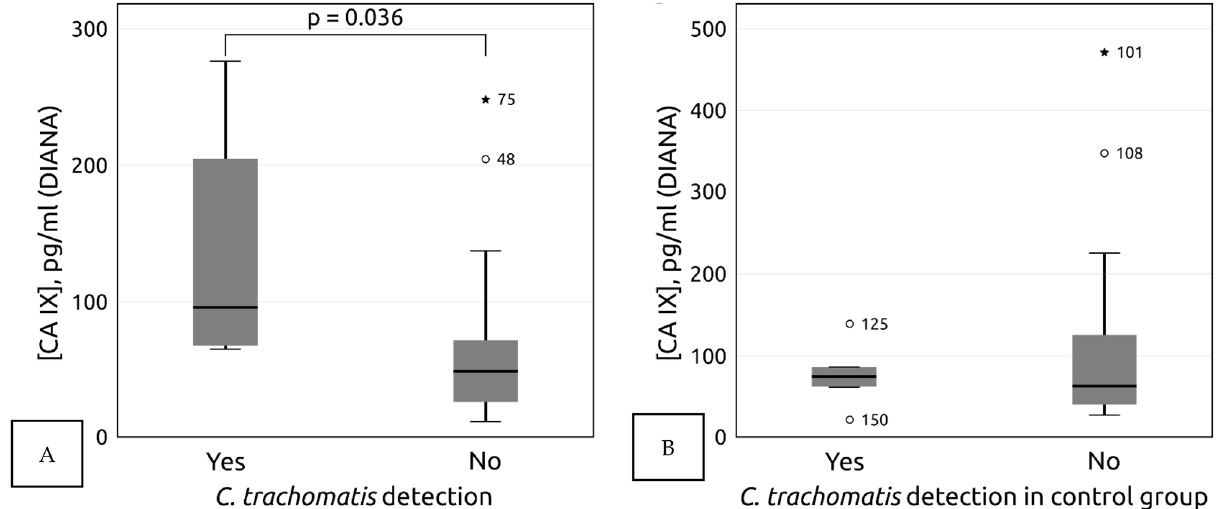
Figure 3. ( A ) Difference of mean s-CAIX level among ≥ HSIL patients (on the left C. trachomatis positive N = 6, on the right and C. trachomatis negative women N = 18). ( B ) Difference of mean s-CAIX level among controls (on the left C. trachomatis positive N = 5, on the right C. trachomatis negative N =